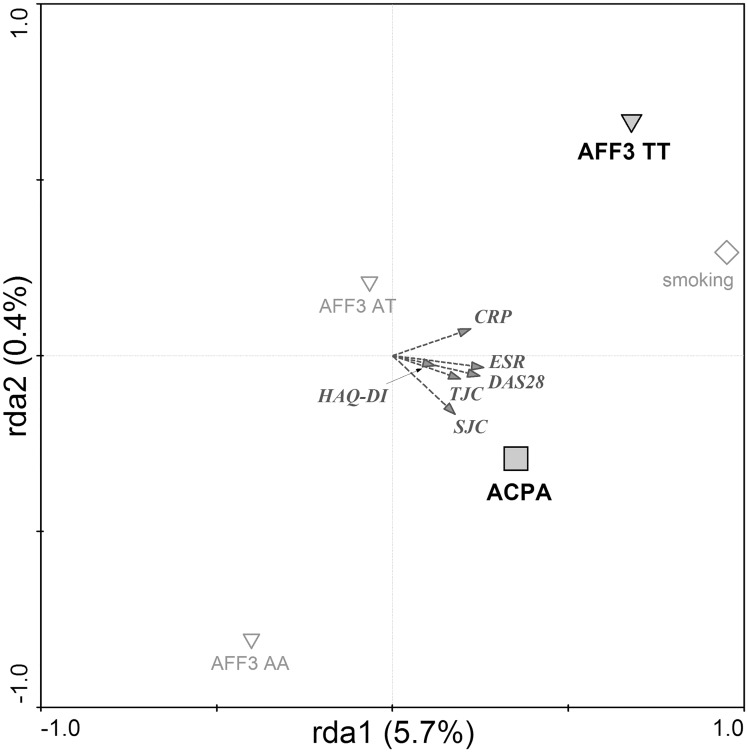
Factors associated with clinical severity in RA.Redundancy analysis plot showing that risk alleles in AFF3 gene, together with ACPA positivity are associated with higher clinical severity of RA. ACPA—anti-citrullinated peptides antibodies (□); AFF3 (TT, AT, AA)–genotypes in AFF3 gene (T risk allele) (▽). Diagram reading clue: Symbols are genetic and serologic factors. Large bold symbols represent genotypes and antibody presence significantly influencing the clinical parameters of disease severity (DAS28, CRP, ESR, TJC, SJC, HAQ-DI). Small empty symbols represent other factors and genotypes of selected genes. Direction of arrow indicates which of the clinical factors are associated with the genetic and serologic parameters and the length of the arrow indicates the magnitude of the association.